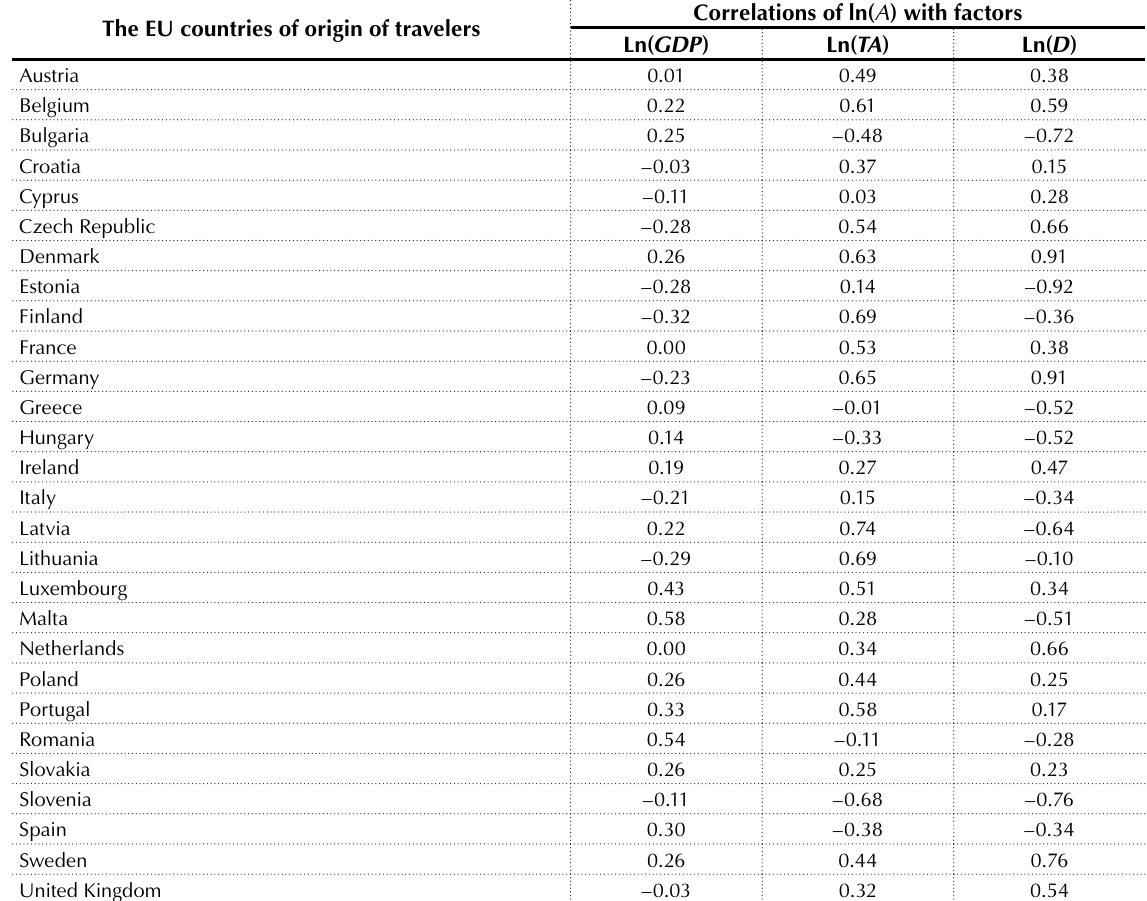
Table 8. Correlations between trips to the 6 BSEC countries and their factors, by country of origin of